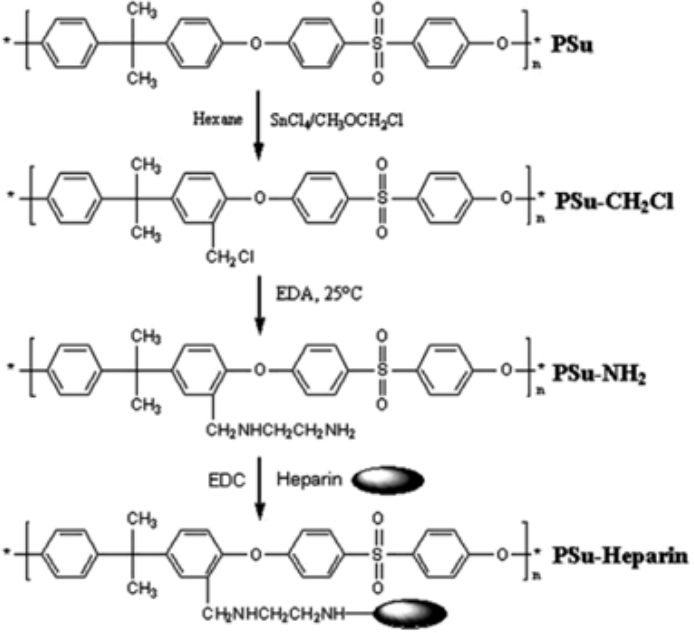
Figure 10. Scheme of the chemical activation of PSF film (reproduced with permission after [84]).